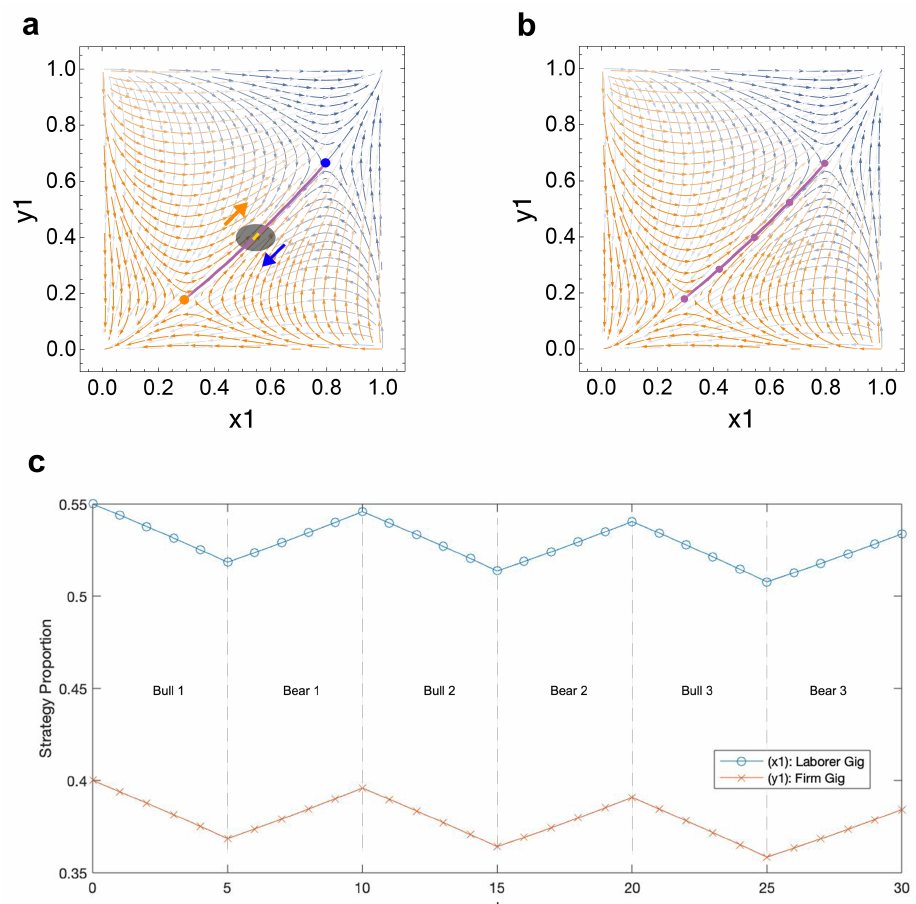
Figure 8. Theoretical market demonstration No. 2: Evolution of strategy densities under market influence with initial conditions ( 0.55,0.40 ) , the attractor position at n = 0.5, an approximation for a point in the trapping zone; n = 1, a bull market; ω = 0.01; and theoretical payoff matrices from Figure A6 in Appendix B. ( a ) Trapping zone orbit. ( b ) Attractor arc. ( c ) Labor strategy oscillation over three market periods. In ( a ), the trapping zone orbit is plotted in yellow, and attractor positions at n = 0 and n = 1 are represented in orange and blue, respectively. Directional dynamics during bear and bull markets are represented by the orange and blue arrows, respectively. In ( b ), we plot a reference attractor arc in purple with attractor positions when n = 0, n = 0.25, n = 0.5, n = 0.75 and n = 1. ( c ) visualizes the fluctuation in firm and laborer preferences for gig strategies over three market